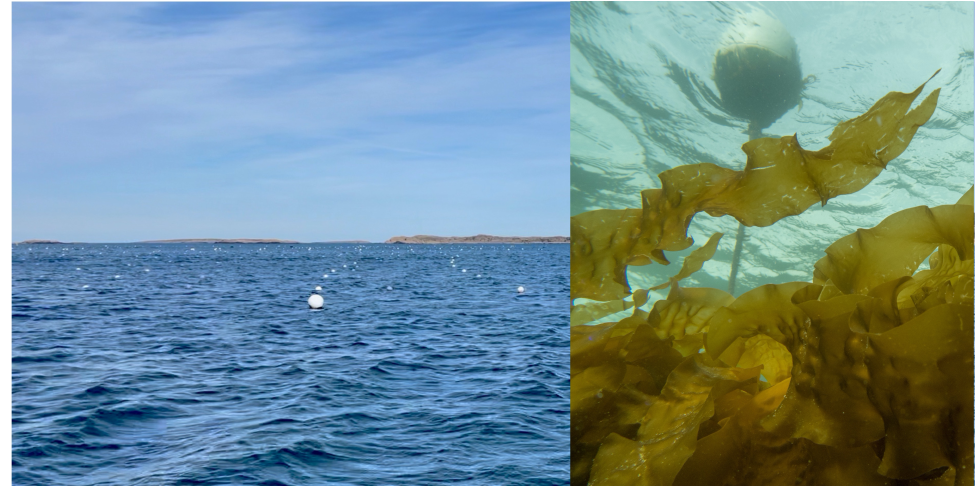
Figure 2. The Nordic SeaFarm site outside of Grebbestad in Sweden. Rows of buoys seen at the surface to the left and the kelp growing on the ropes below the surface to the right. ( Left : photo courtesy of SMaRC, Right : photo courtesy of Nordic SeaFarm).